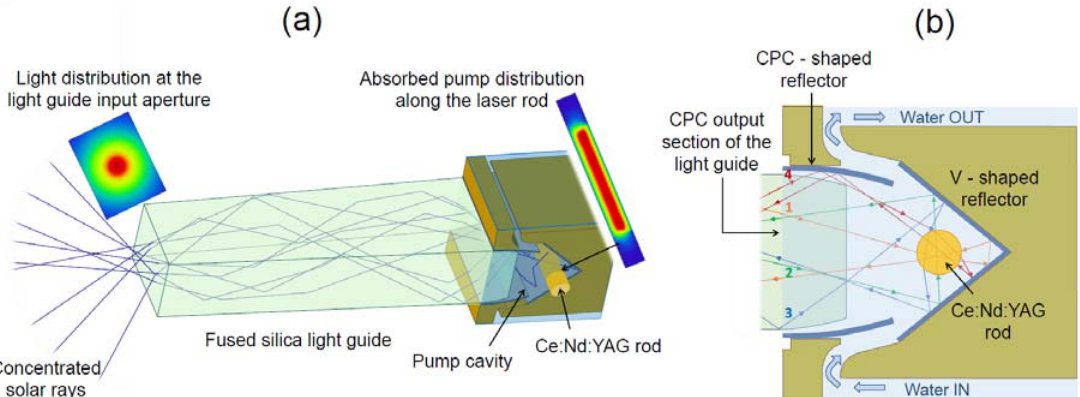
Figure 4. Schematic designs of ( a ) the Ce:Nd:YAG solar laser head with rectangular light guide and ( b ) the V ‐ shaped pump cavity with the passage of pump rays within the laser rod. The insets of Figure 4a represent the solar rays’ distribution at both the light guide input aperture (left) and along the laser rod (right).